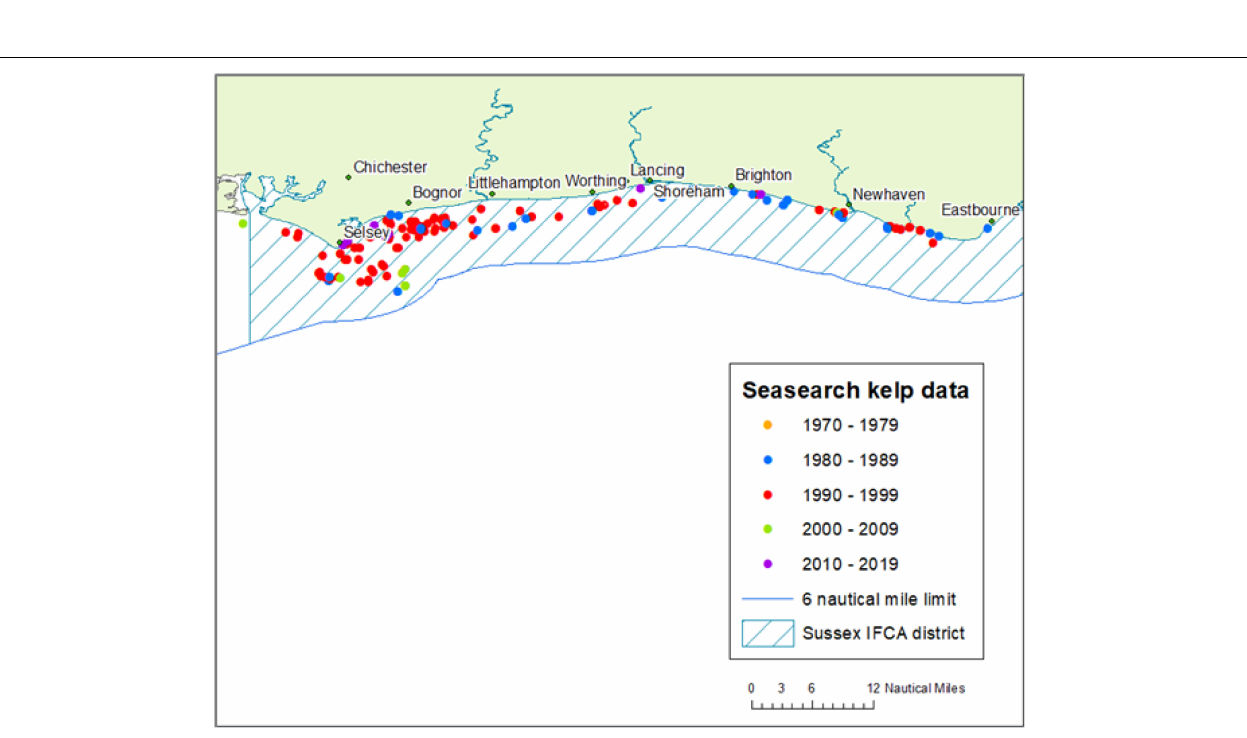
Frontiers in Ecology and Evolution |